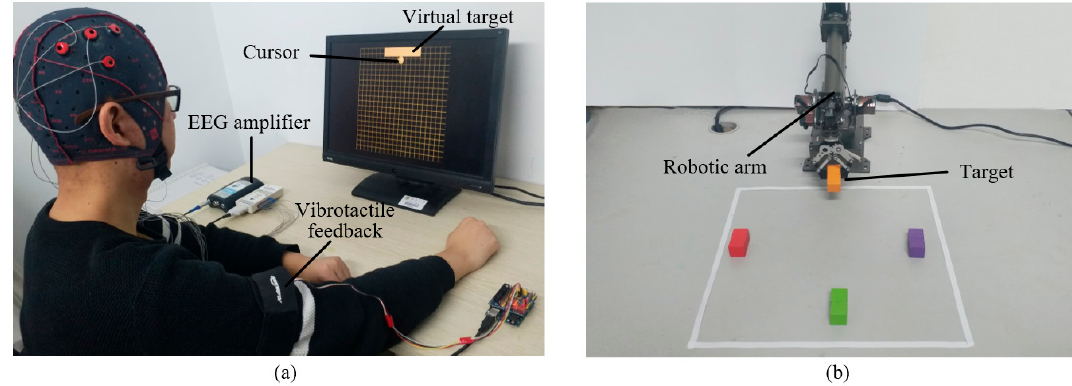
Figure 3. A subject with our BCI-driven system ( a ) and the teleoperation robotic arm ( b ).